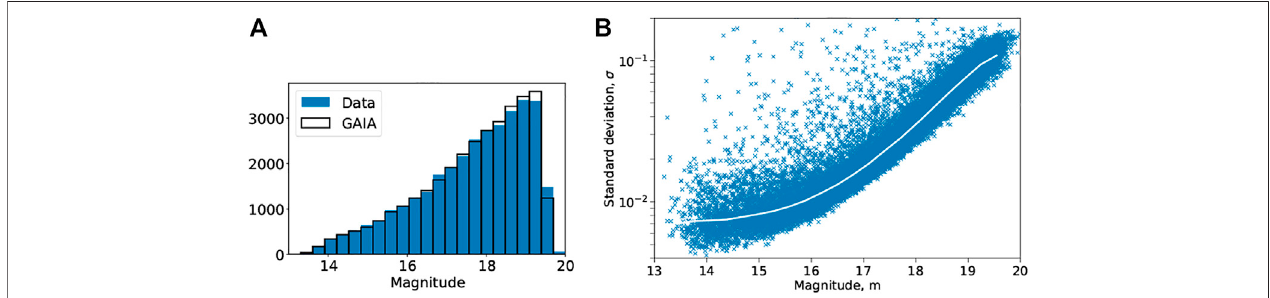
FIGURE5| Photometrystatisticsforonenight: (A) magnitude distribution compared totheGAIA catalog(Prustiet al.(2016);Brown etal.(2021))and (B) standard deviation versus magnitude, with the median dependence shown by the white curve.